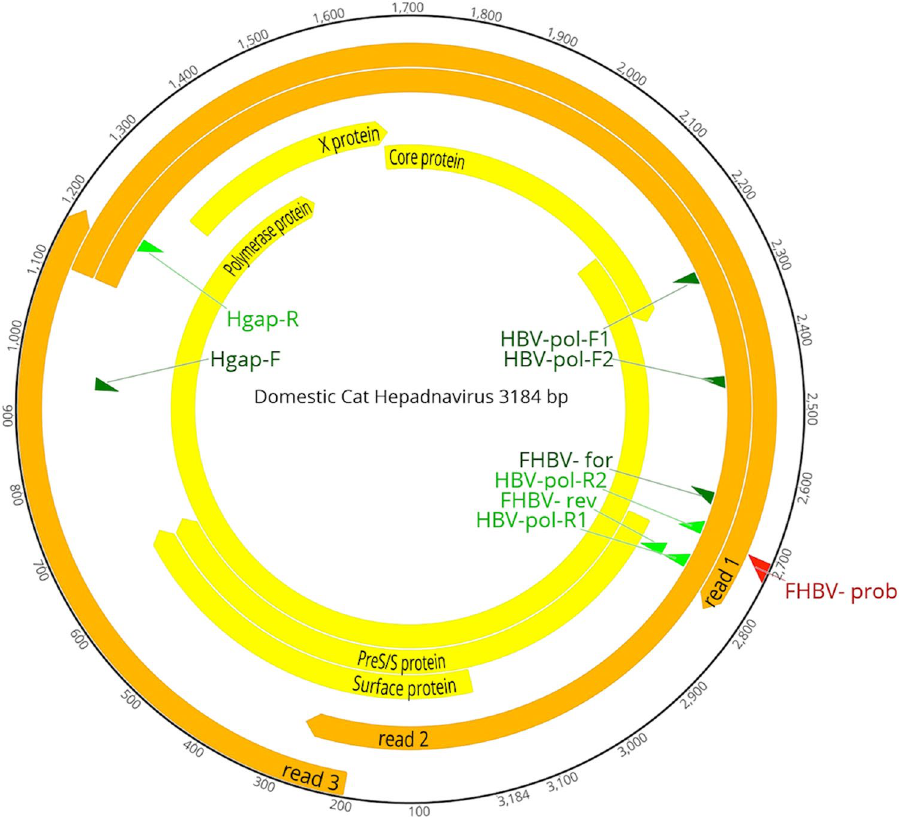
Figure 2. Genome organization of the DCH. The complete genome consists of 3184 bp. The outermost circles represent the read mapping coverage (orange) of the genome. In the innermost circles the proteins encoded by the polymerase, surface, core and X ORFs are labelled (yellow), as are the positions of the primers (green) and probe (red) used in this study (Table 2) are